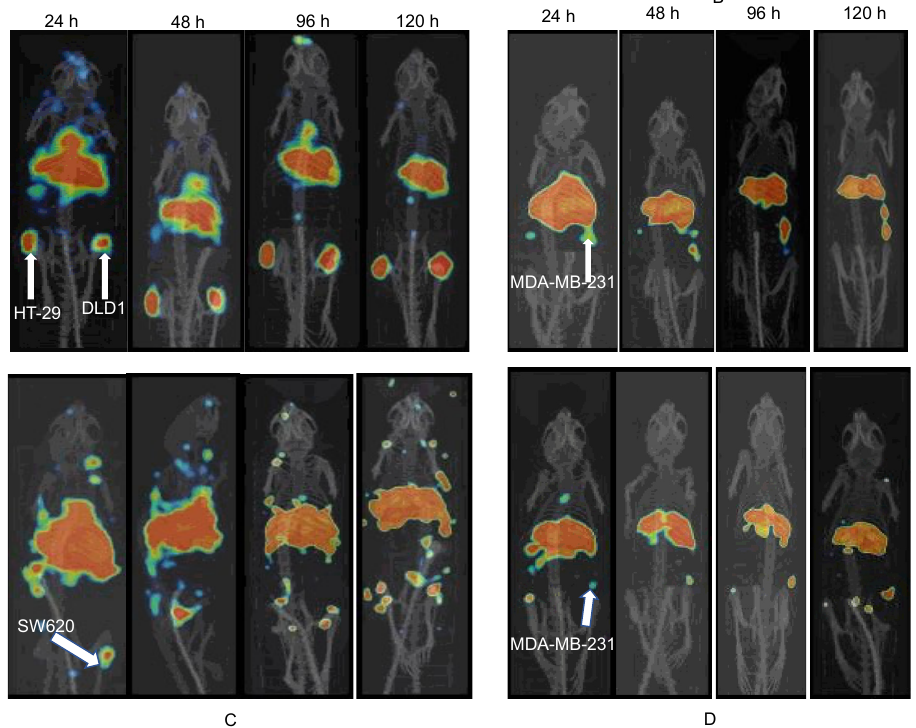
Figure 4. MicroPET imaging of mice bearing EGFR-positive xenografts following a tail vein injection of 89 Zr-matuzumab. ( A ) Mouse bearing DLD-1 (right flank) and HT 29 (left flank), ( B ) MDA-MB-231, ( C ) SW620, and ( D ) MDA-MB-231 after pre-dosing with unlabeled matuzumab prior to 89 Zr-matuzumab (blocking studies) xenografts. To understand the epitope specificity of matuzumab and nimotuzumab, mice bear- ing EGFR-positive HT-29 (left flank) and DLD-1 (right flank) xenografts were pre-dosed vail a tail vein with 50-fold excess (compared with imaging dose) nimotuzumab, followed by a tail vein injection of 89 Zr-matuzumab. The mice were imaged (up to 120 h post-injec- tion) followed by biodistribution immediately after imaging (Figure 6A,B). Tumor uptake of 89 Zr-matuzumab in HT-29 and DLD-1 xenografts was not affected by nimotuzumab pre-dosing, showing that the two antibodies bound to different epitopes and could be used simultaneously for imaging and therapy.